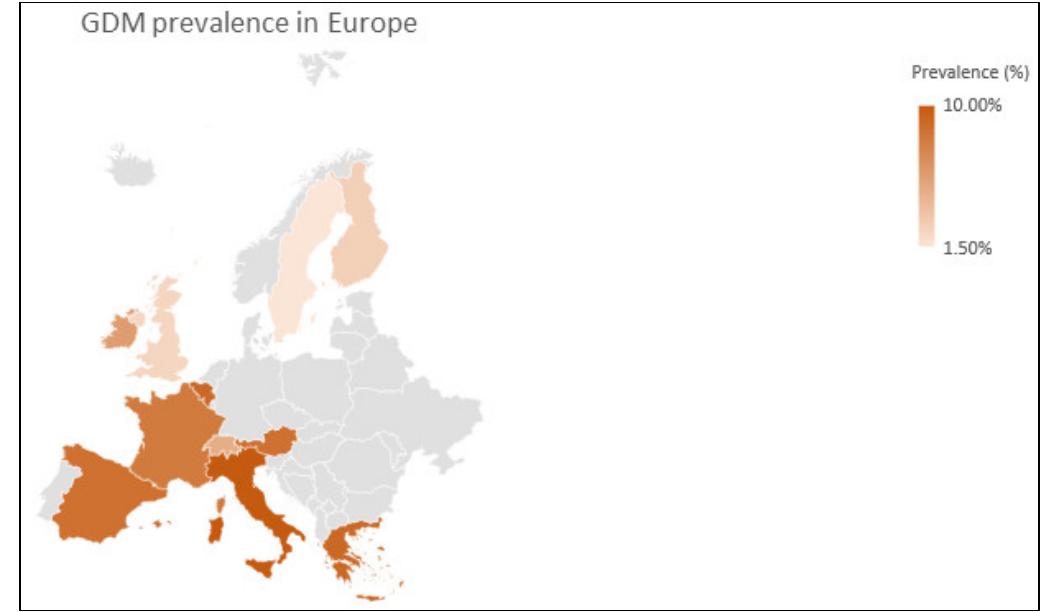
Figure 2. Mean GDM prevalence and 95% CI in: ( a ) 11 European countries; ( b ) Northern, Western, and Southern Europe.